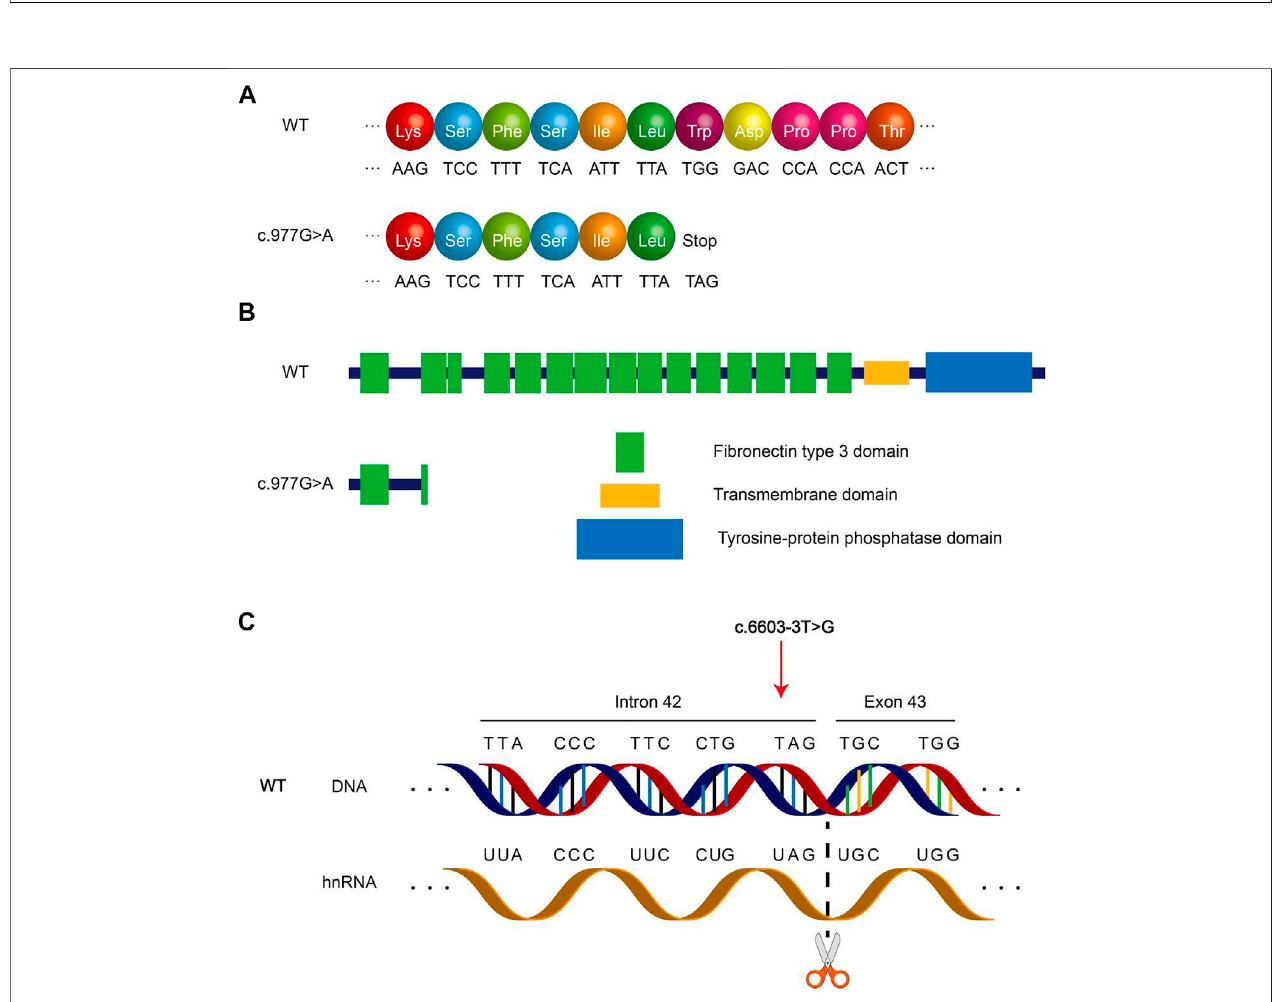
FIGURE 4 | Schematic diagram of PTPRQ mutation. (A) Amino acid coding diagram of mutation c.997 G > A. (B) Schematic diagram of PTPRQ peptide chain truncation caused by mutation c.997 G > A. (C) Schematic diagram of mutation c.6603-3 T > G altering hnRNA splicing.